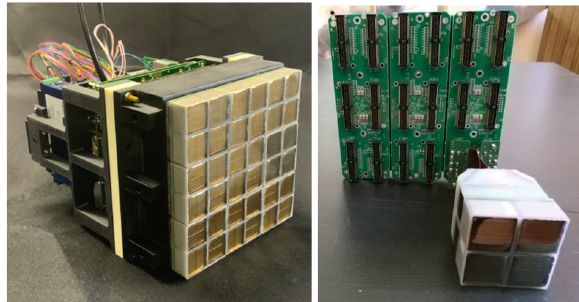
Figure 1. Assembled photodetection module (PDM) of EUSO- SPB2’s FT (left) and Elementary Cell (EC) with 64 × 4 = 256 de- tection channels (right).